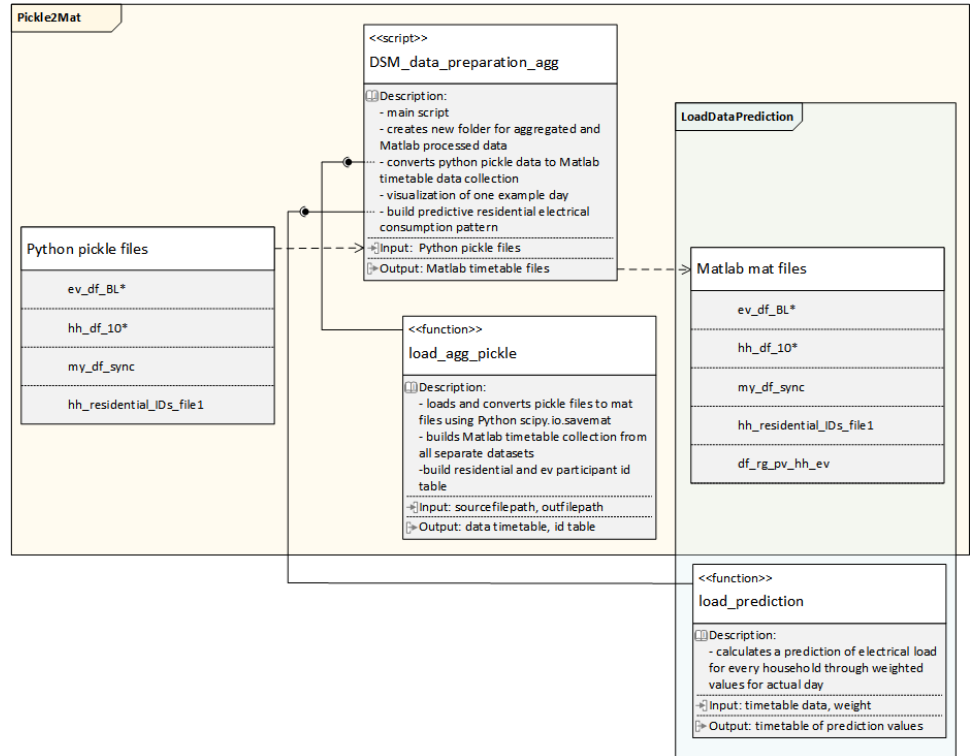
Figure A1. Data conversion framework (*: placeholder for all subsets) .